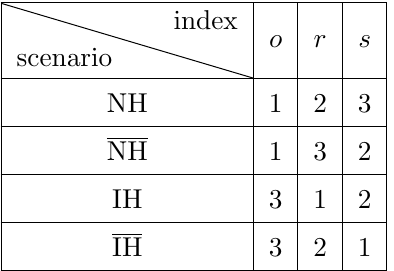
Table 2 . Index arrangements between the naming and numbering of the light neutrino states. The overbarred scenarios describe the case, when the loop-generated mass m r becomes bigger than the loop-corrected seesaw mass m s . The mass m o is always 0 in our